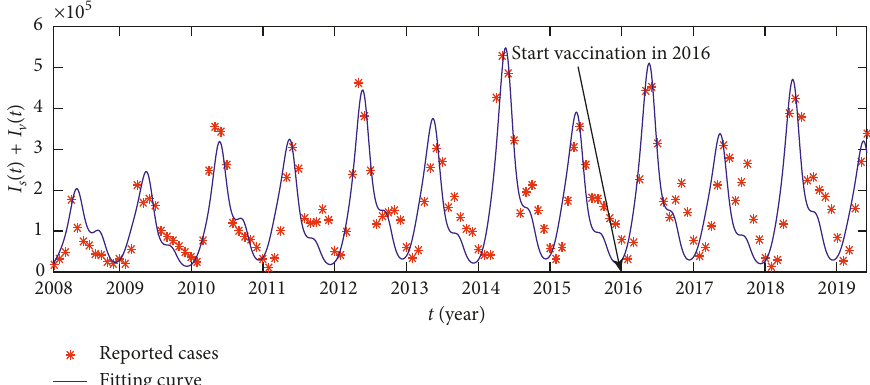
Figure 3: The comparison between the reported HFMD cases in mainland China and the simulation of I ( t ) + I ( t ) of system (1) from s v January 2008 to June 2019. The values of parameters are given in Table 1. The initial conditions are S ( 0 ) � 9 . 23 × 10 7 , E s ( 0 ) � 8 × 10 4 , ( 0 ) � 2 × 10 4 , I e ( 0 ) � 6 × 10 4 , R � 1 × 10 5 , V ( 0 ) � 0 , E ( 0 ) � 0 ,I ( 0 ) � 0 , I e ( 0 ) � 0 , R ( 0 ) � 0. It should be noted that we take k � 0 I s s v v v s v before 2016. Table 2: Chi-square values and degrees of freedom from January Year Chi-square value 68.07 33.19 DF 82 28 104.14 41.34 Note: AV denotes the accepting value is at 5% significant level with degrees of freedom